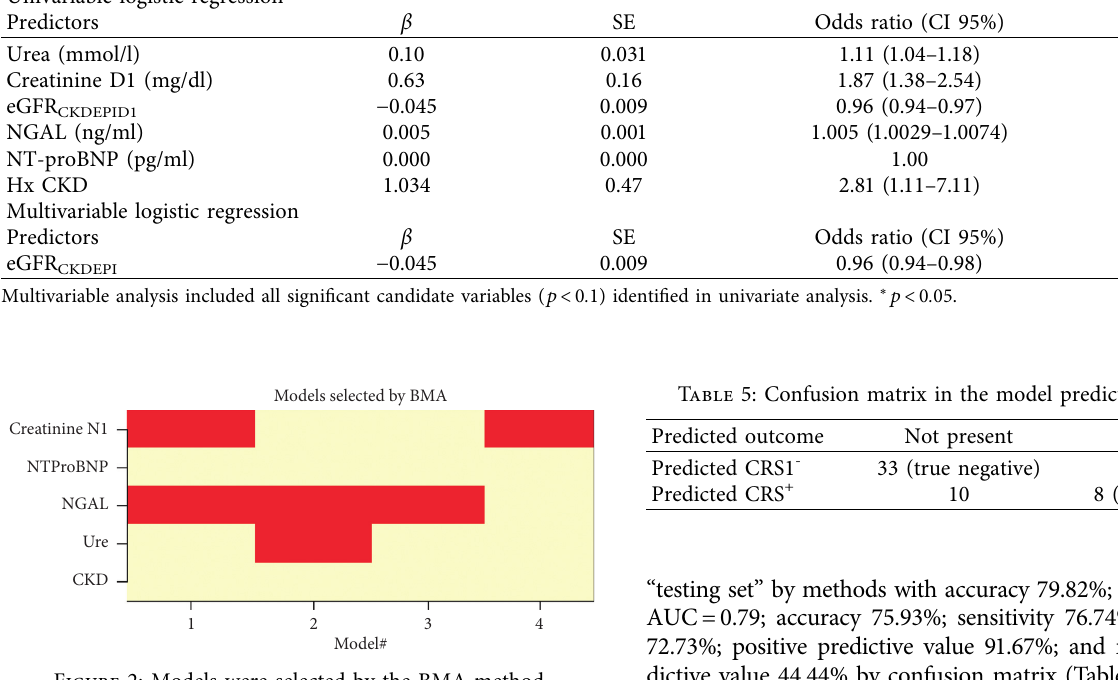
Figure 2: Models were selected by the BMA method.